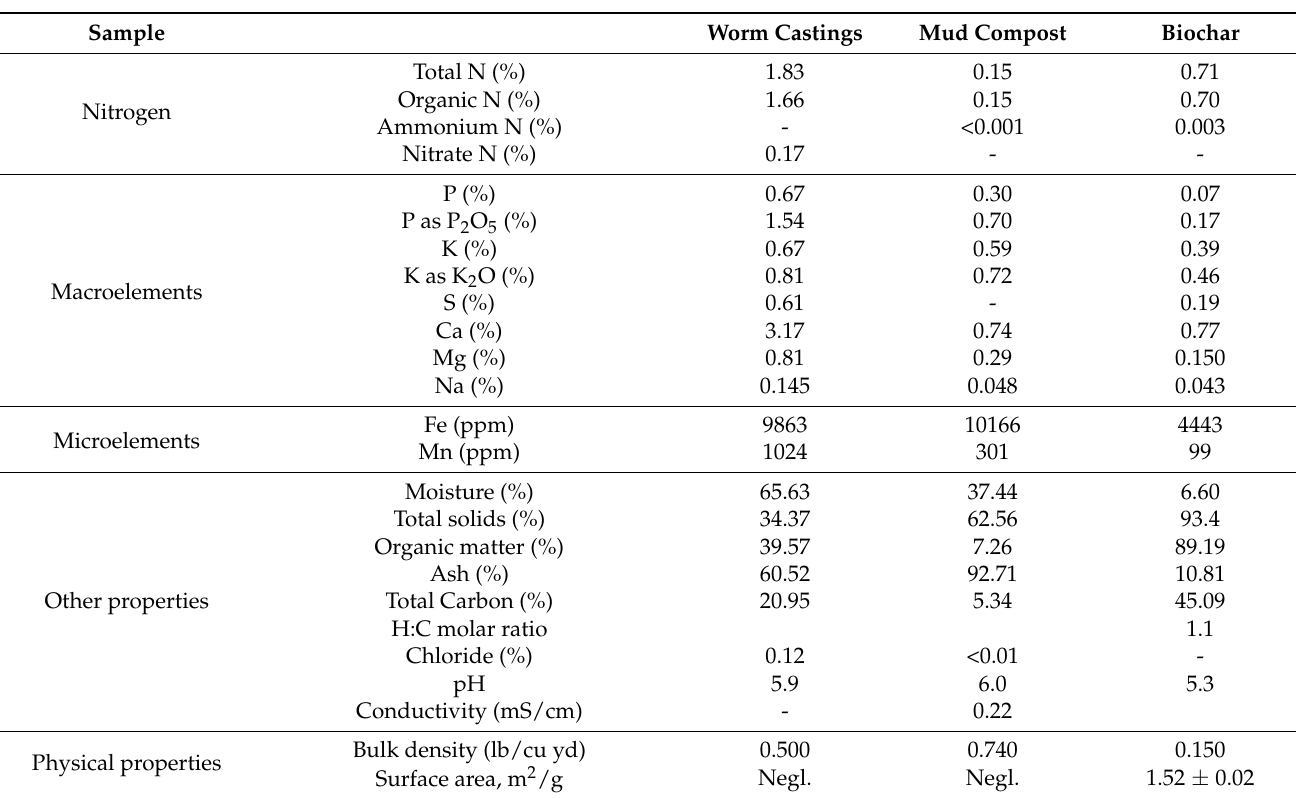
Table 1. Various physical and chemical properties for worm castings, sugarcane filter mud compost, and biochar samples (taken from Lima et al.,